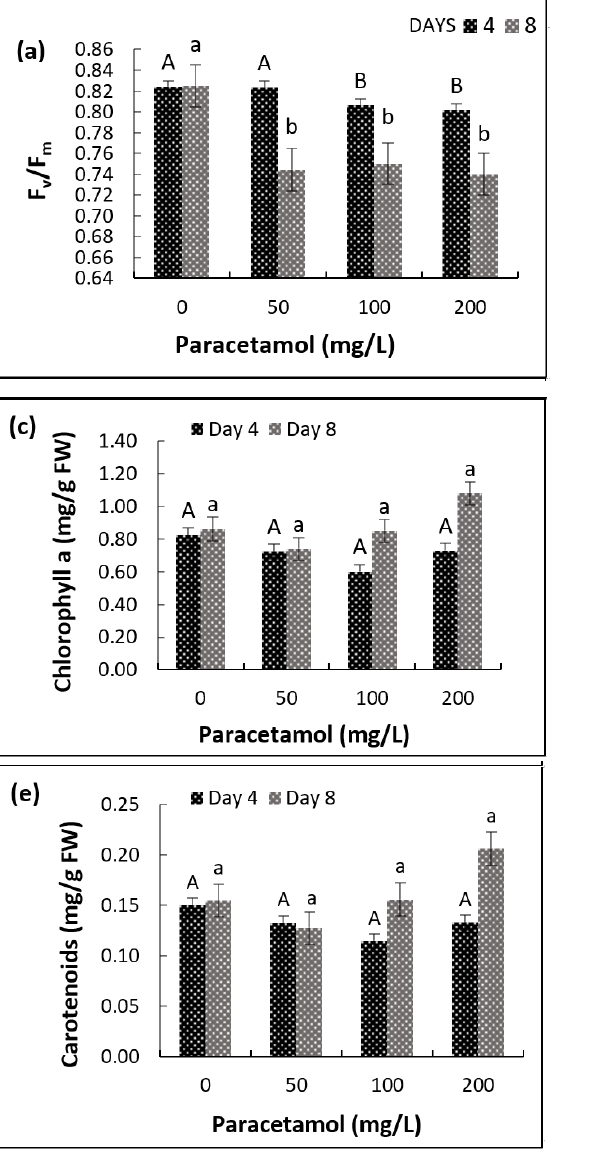
Figure 3. Effects of different paracetamol treatments and exposure periods on ( a ) F v /F m , ( b ) quantum yield of electron transport in photosystem II (ΦII), ( c ) Chl a, ( d ) Chl b, ( e ) carotenoids and ( f ) total chlorophyll (mg/g FW). Error bars represent ± S.E. of three biological replicates. Means with different upper-case and lower-case letters indicate significant differences ( p ≤ 0.05 ) at days four and eight, respectively. Table 2. Results of two-way ANOVAs showing the effects of different paracetamol treatments, ex- posure periods, and their interactions on chlorophyll fluorescence (F v /F m and ΦII), Chl a, Chl b, ca- rotenoids, and total chlorophyll content (mg/g FW) in spinach.